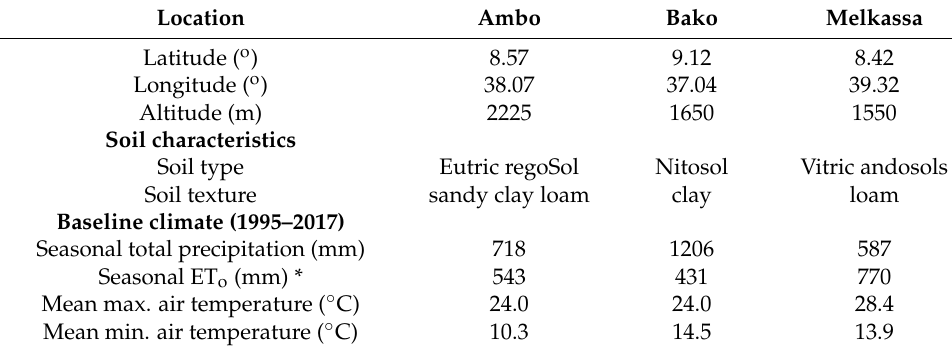
Table 1. Characteristics of the study sites in Ethiopia. Location Ambo